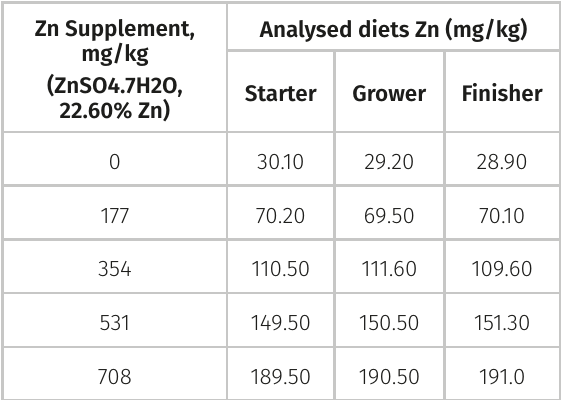
Table II. Supplemental and analysed Zn concentrations in starter, grower and finisher diets 1